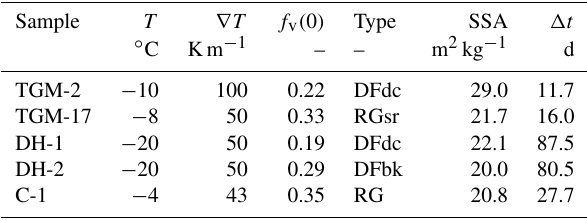
Table 1. List of snow samples from laboratory TGM experiments with temperature, temperature gradient, initial ice volume fraction, initial snow type and sub-type, specific surface area (SSA), and du- ration of the experiment. The corresponding anisotropy evolution is shown in Fig.